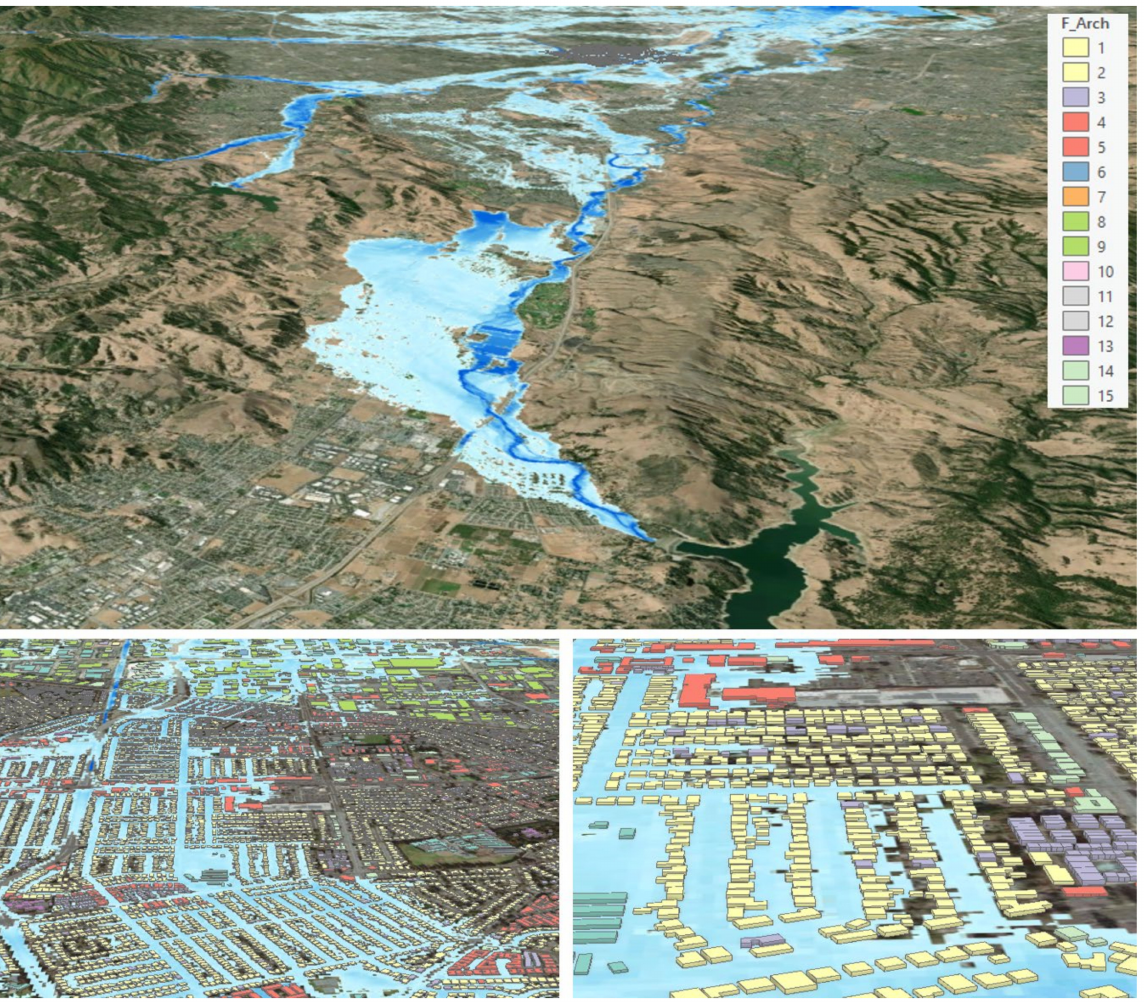
Figure 13. A 3D view for the Santa Clara County with buildings color-coded based on their archetypes and overlaid with the flooding (hazard) layer to identify the exposed buildings with close-up views on one of the flooded